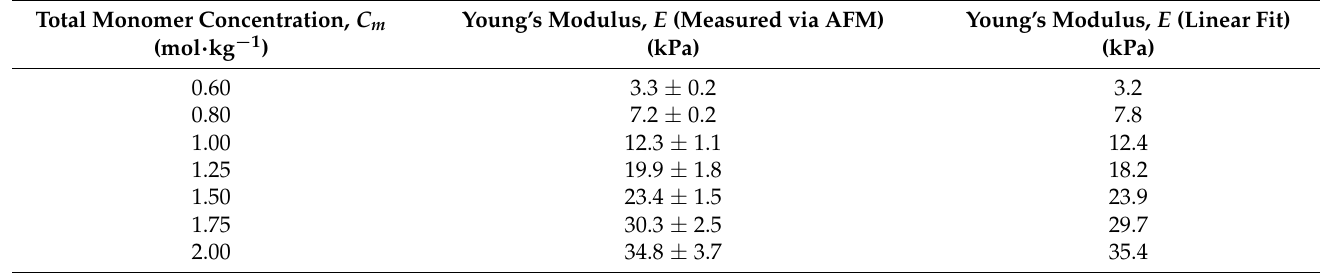
Table 3. Young’s modulus of hydrogels measured via AFM and linear fit (see Figure